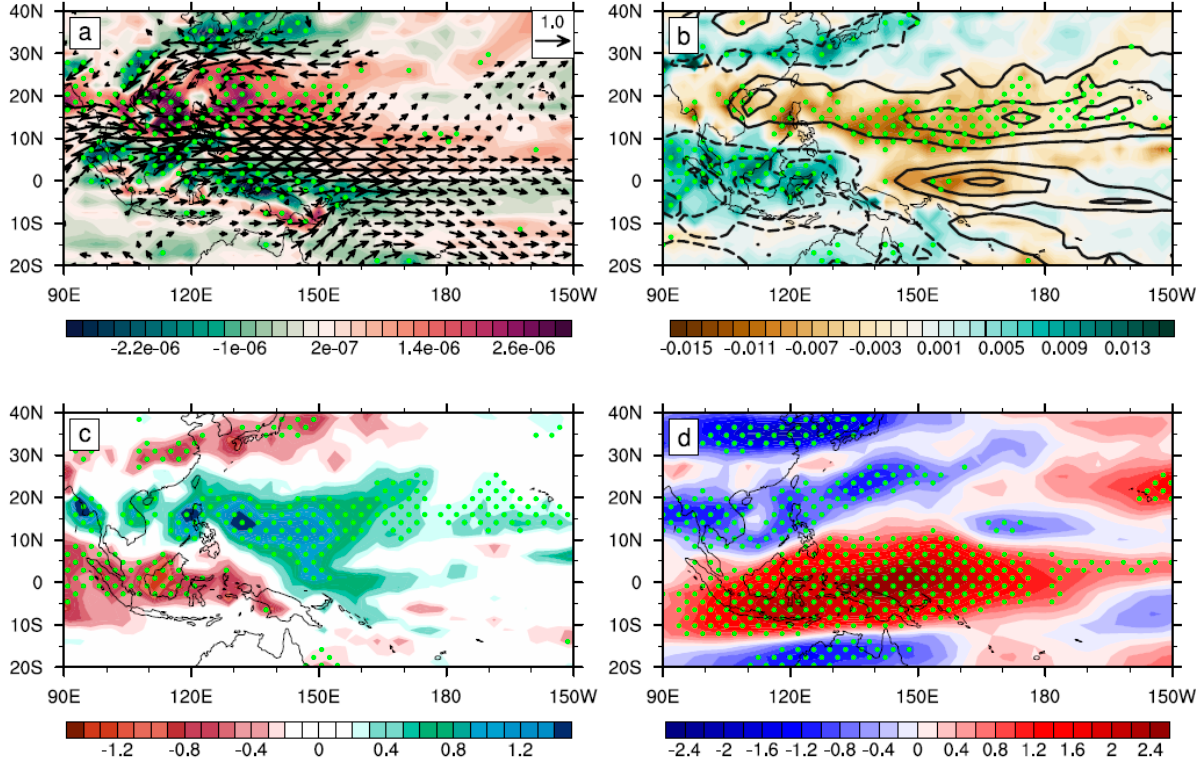
Figure 9. Regression of ( a ) 850 hPa winds (vectors, exceeding the 95% significance level based on the two-sided Student’s t -test, unit: m/s) and relative vorticity (shading; s − 1 ) anomalies, ( b ) 500 hPa vertical velocity (shading, Pa/s) and 700 hPa specific humidity (contours, interval of 0.1 g/kg; zero contours are omitted) anomalies, ( c ) surface precipitation rate (shading, mm/day) anomalies, and ( d ) vertical wind shear (shading, m/s; 200 hPa minus 850 hPa) anomalies in JJA onto the normalized JJA TCGF index during 1980–2020. The green dots indicate the significant relative vorticity, vertical velocity anomalies, surface precipitation rate anomalies, and vertical wind shear anomalies above the 95% confidence level based on the two-sided Student’s t-test, respectively.